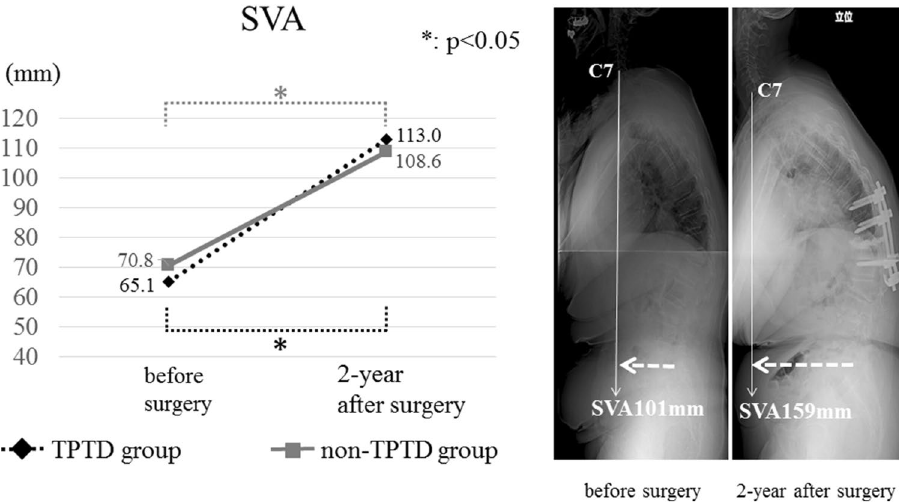
Figure 1. Mean sagittal vertical axis (SVA) observed preoperatively and 2 years after surgery; the figure shows that there was significant deterioration in both groups ( TPTD teriparatide).